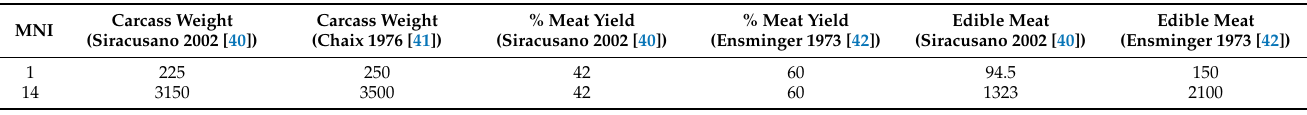
Table 8. Carcass weight, meat yield, and edible meat for rustic cattle breeds raised in traditional production conditions (information in